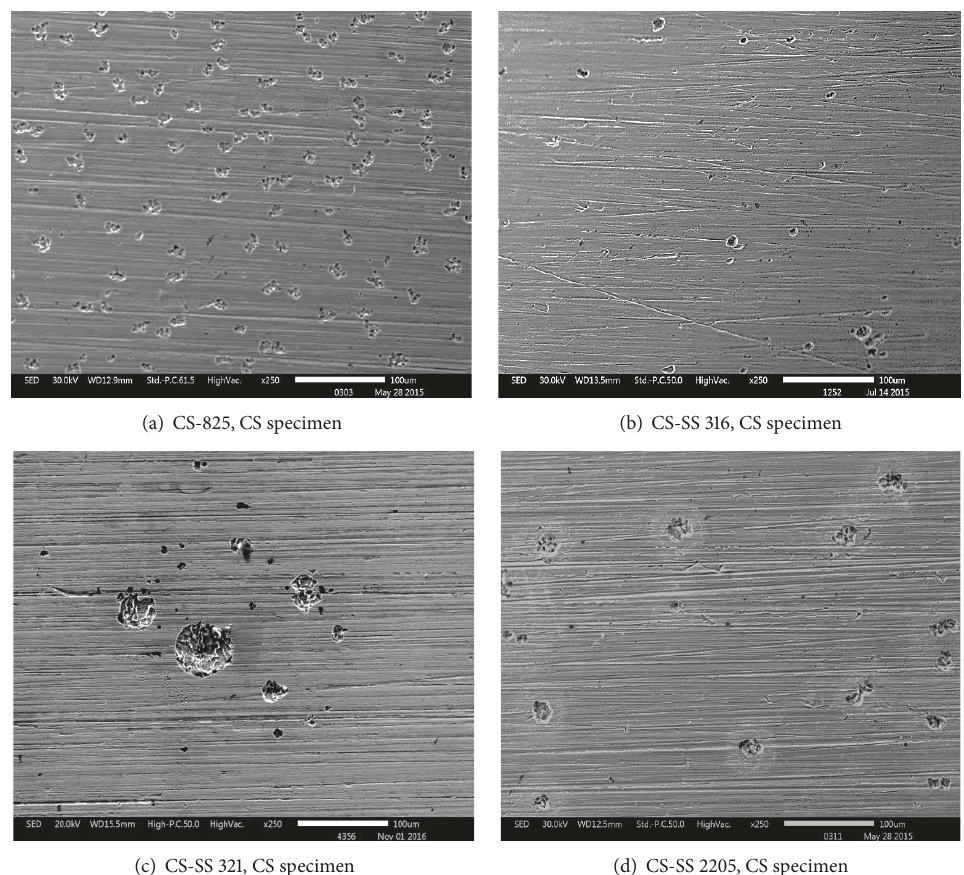
Figure 8: SEM micrographs of carbon steelspecimens coupled with differentalloys after polarization experiments in stagnant deaerated3.5% ABS solution at 60 ∘